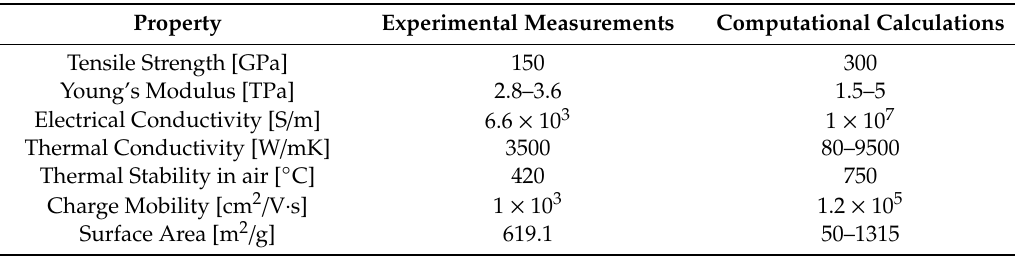
Table 1. Properties of carbon nanotubes